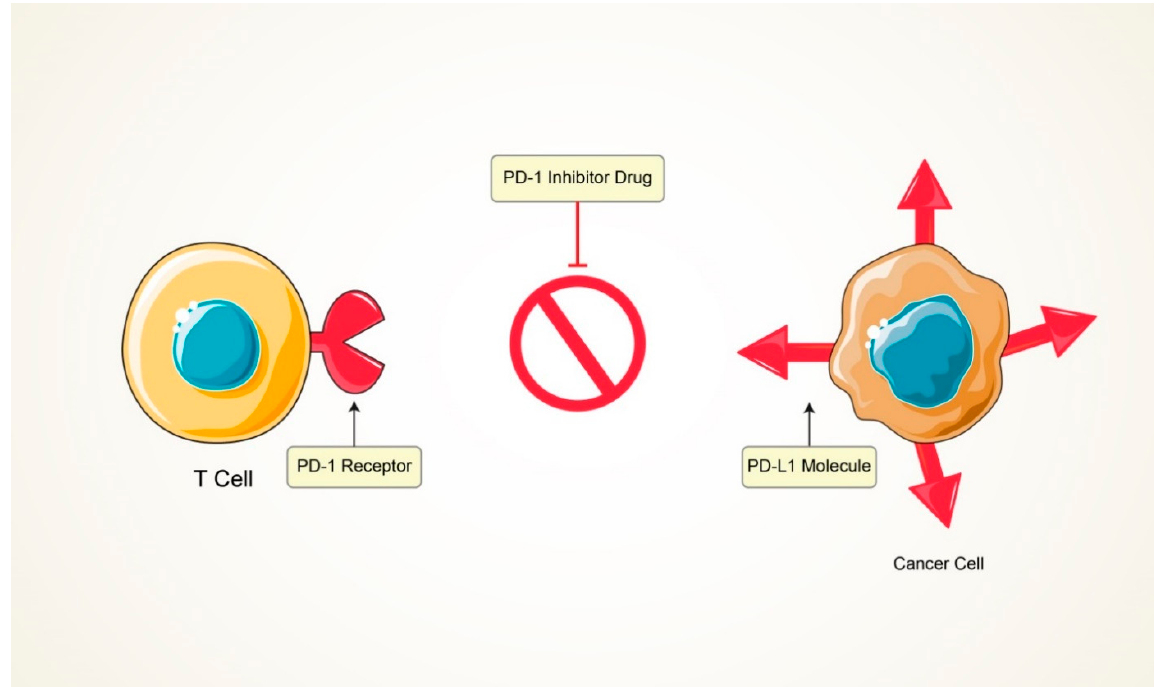
Figure 4. The mechanism of returning the exhausted T cell to an activated T cell against cancer cell. By showing a molecule called PD-L1, the normal cells send white flag to the immune system. The signal is detected by T cells via PD-1 protein. The protein binds with PD-L1 and prevents T cells from attracting body’s own cells.